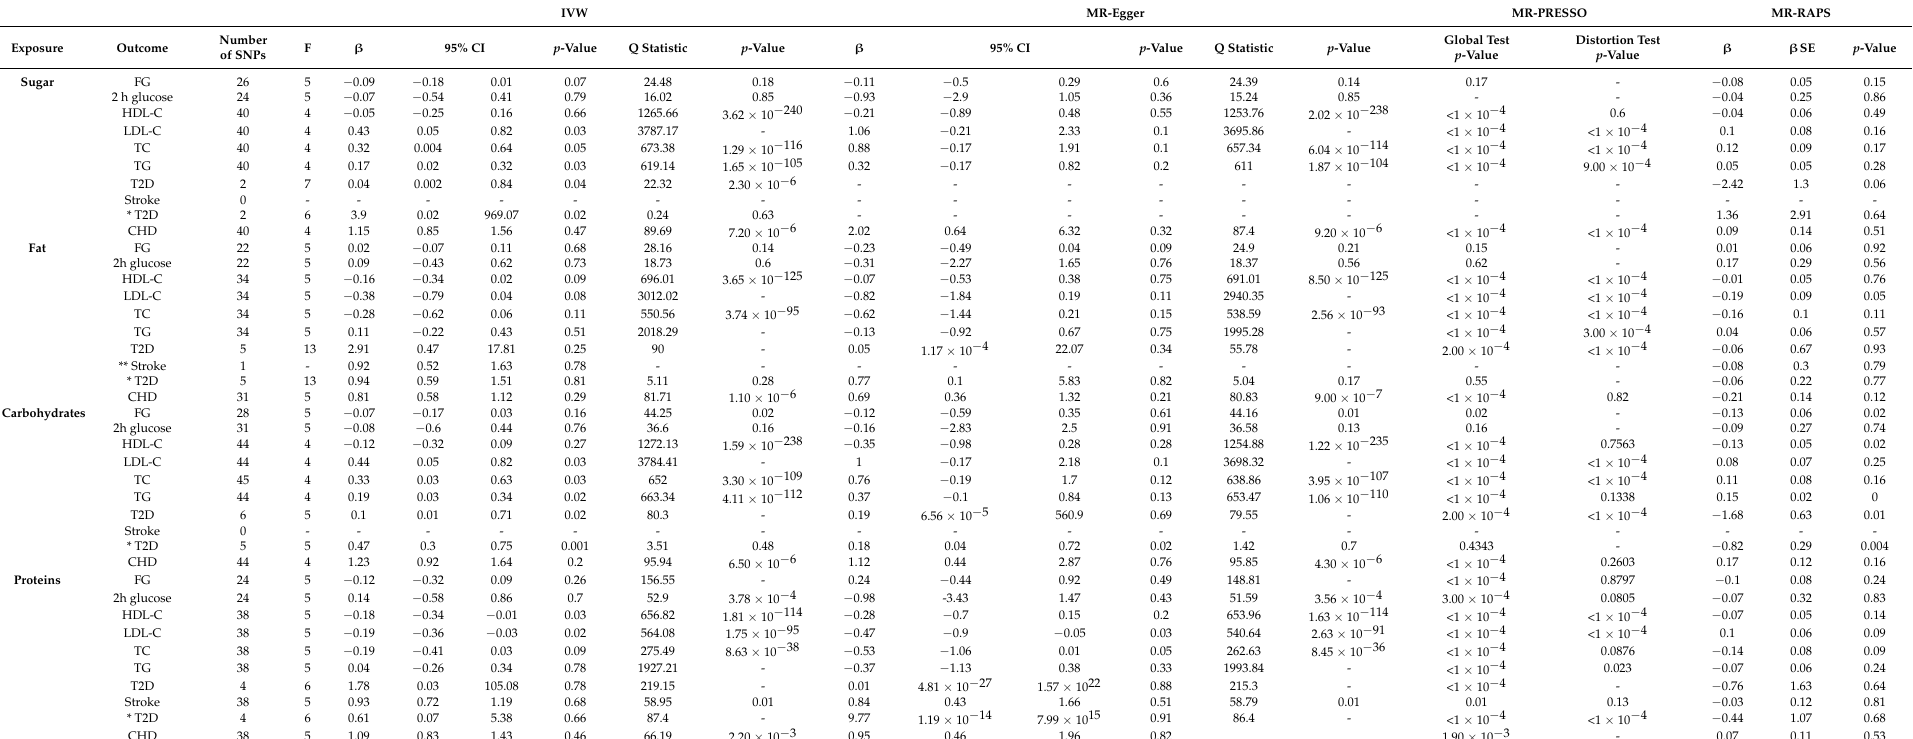
Table 1. Two-sample MR exposure–outcome associations per macronutrient